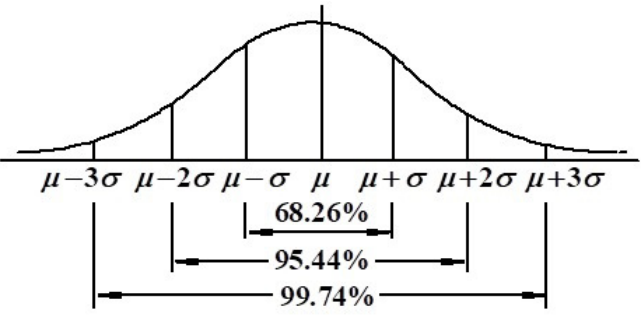
Figure 4. The 3 σ criterion of the normal